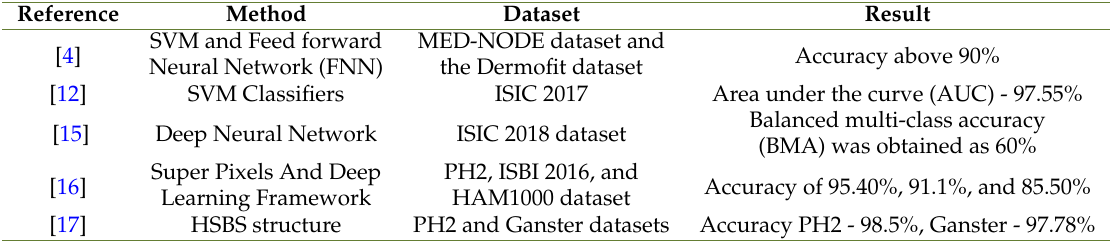
Table 1. Literature Survey